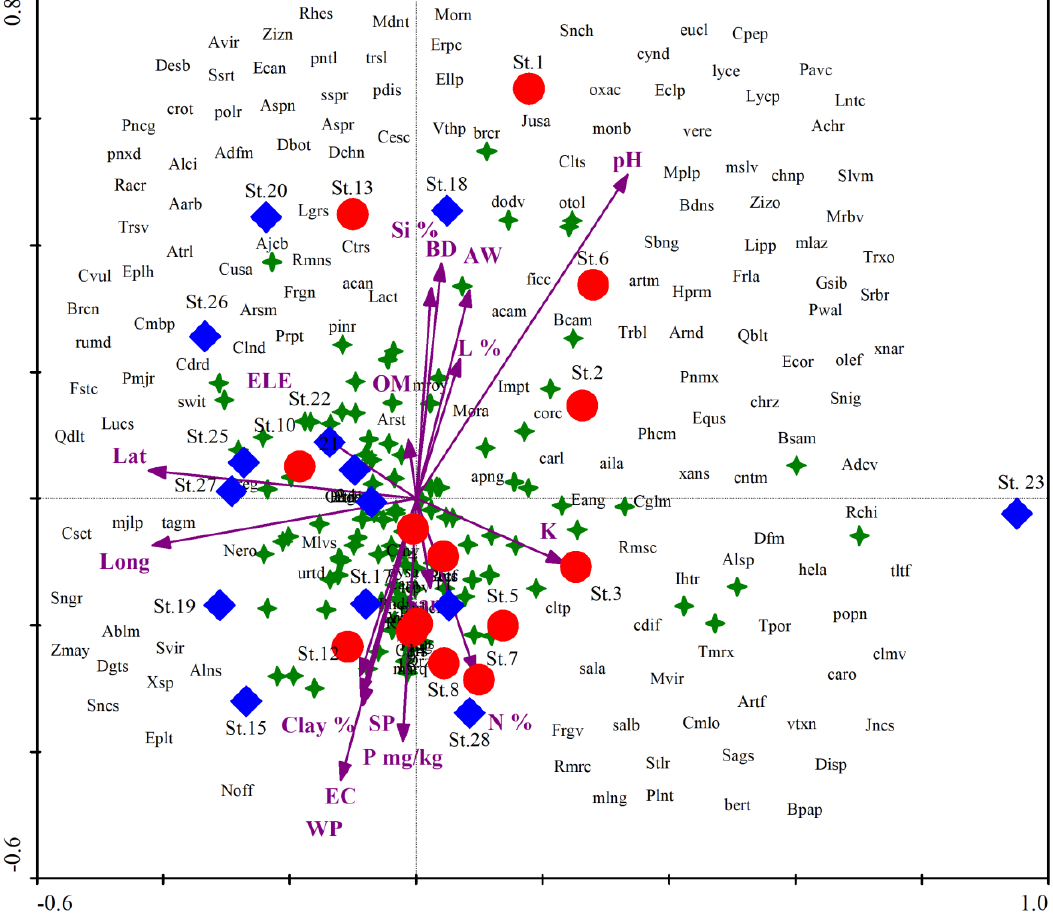
Figure 7. CCA-ordination and biplot showing vegetation distribution in 30 stands along the Panjkora river basin. Note: St. (Stand number); Environmental variables legends are same as that in Table 2; Species codes are same as that in Table S2.